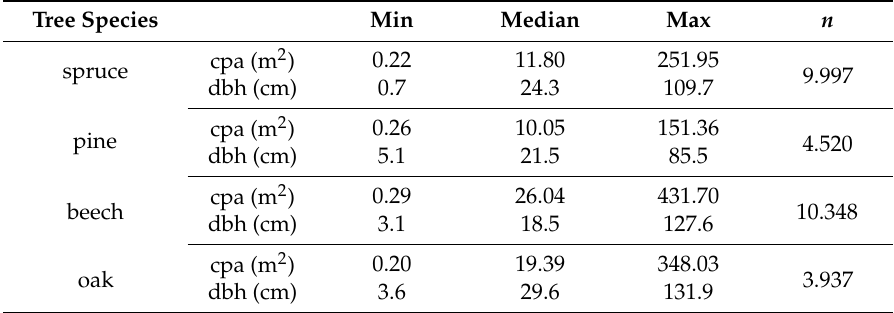
Table A2. Characteristics of the crown projection area-dataset used for fitting Equation